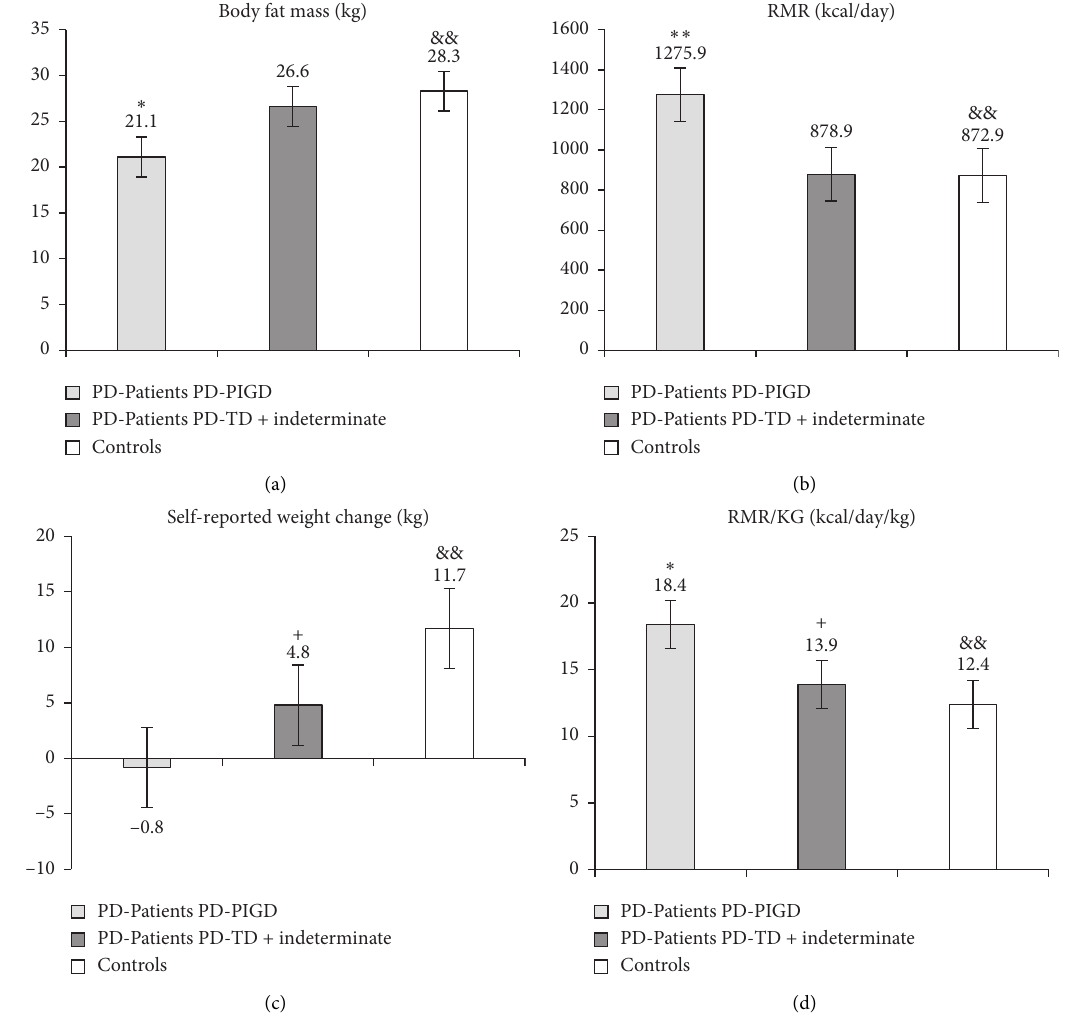
Figure 1: Body fat mass (a), resting metabolic rate (RMR) (b), self-reported weight change (c), and RMR per kg of total body weight (d), in